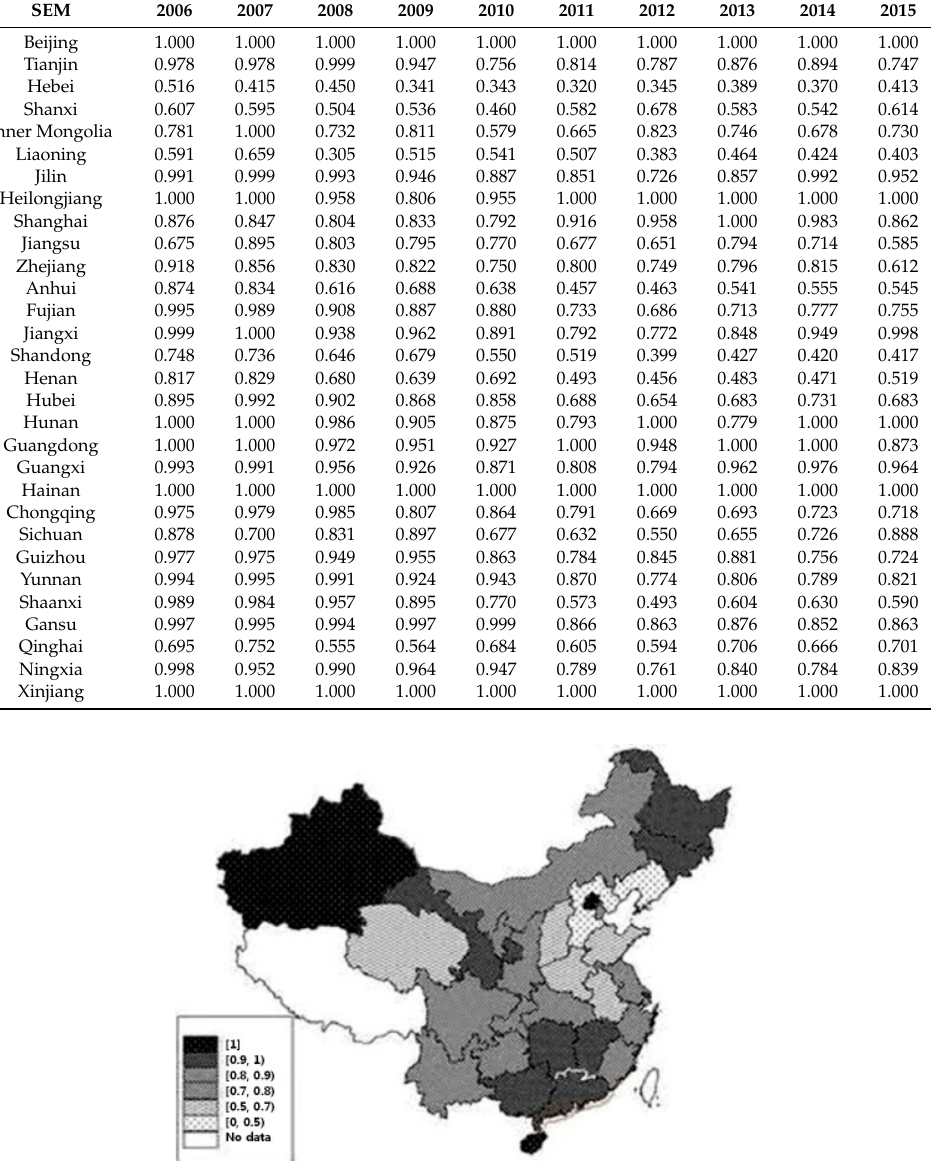
Figure 6. Average scale efficiency under the managerial disposability of 30 provinces in China (2006–2015).